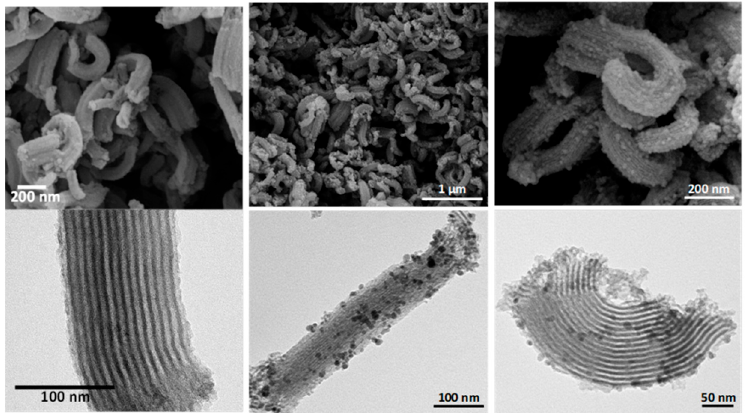
Figure 6. SEM ( top ) and TEM ( bottom ) micrographs of ( left ) S15N mesoporous silica and ( center and right ) HMMSN hybrid magnetic mesoporous nanorods in different locations and with different magnifications.